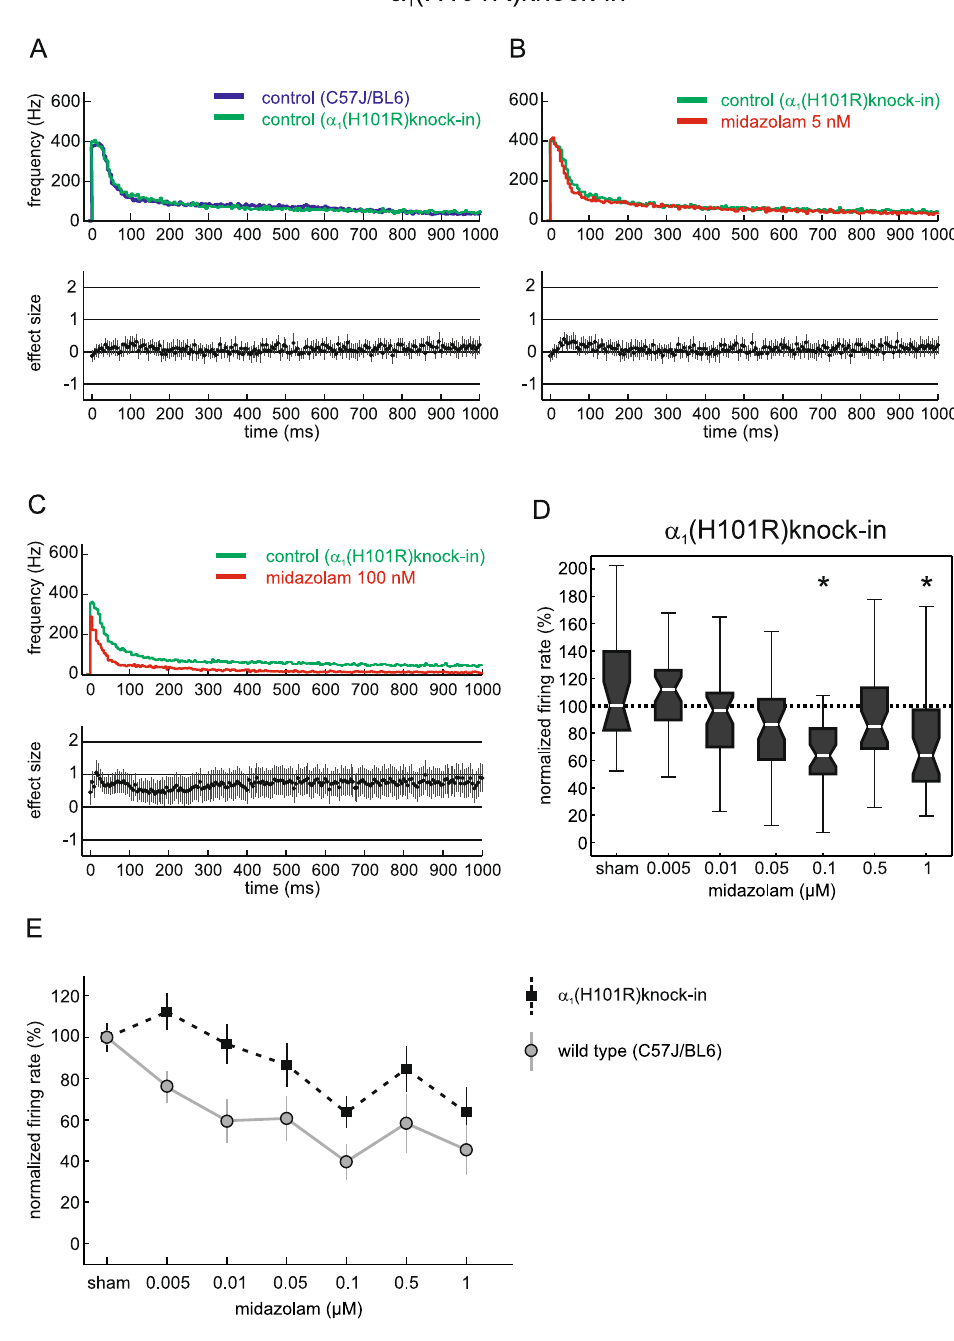
Figure 6. The actions of midazolam on global neuronal activity of organotypic slice cultures from GABA A receptor α 1 (H101R)knock-in mice. ( A ) Comparison of neuronal activity of wild-type mice (dark blue) and α 1 (H101R)knock-in mice (green) under control conditions. No difference between the two genotypes could be detected. ( B ) Actions of 5 nM midazolam (red) versus control condition (green) in slices from α 1 (H101R) knock-in mice. Unlike in the wild-type mice, midazolam’s effect was absent in neocortical cultures from α 1 (H101R)knock-in mice. ( C ) Effect of 100 nM midazolam (red) versus control conditions (green). Only at this higher concentration midazolam depressed cortical activity also in cultures from α 1 (H101R)knock-in mice. ( D ) Depression of the overall action potential firing rate by midazolam in neocortical cultures from α 1 (H101R) knock-in mice. In contrast to wild-type slice cultures (see Fig. 1A) the spontaneous firing rate was significantly depressed only at 100 nM and 1 µ M ( * p < 0.001; Kruskal-Wallis test, post-hoc analysis (Bonferroni) followed by Mann-Whitney U test). ( E ) A comparison of the concentration-dependant actions of midazolam in neocortical cultures from wild-type mice (grey) and α 1 (H101R)knock-in mice (black) given as median and the 95% CI. Note that both curves run nearly